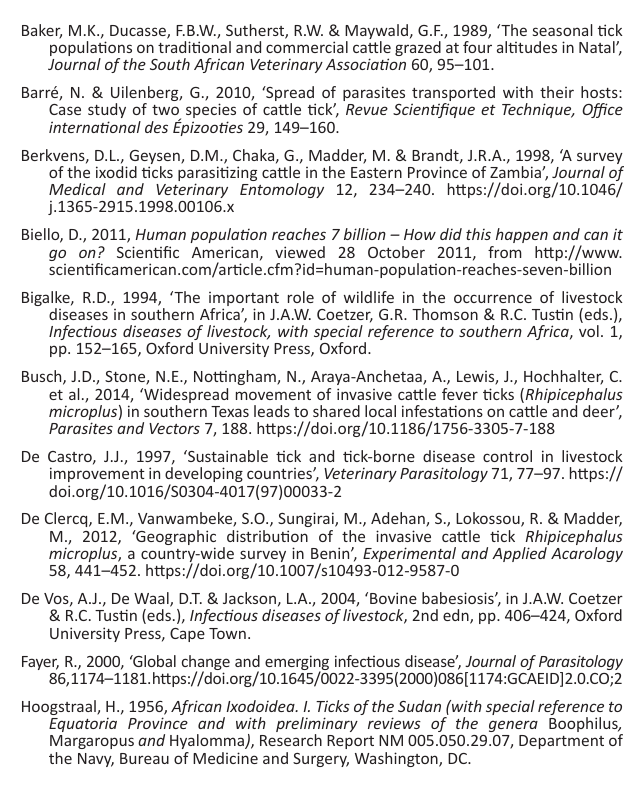
FIGURE 3: Sampling localities where ticks were collected and localities positive for Rhipicephalus microplus in the Northern Cape province in South Africa